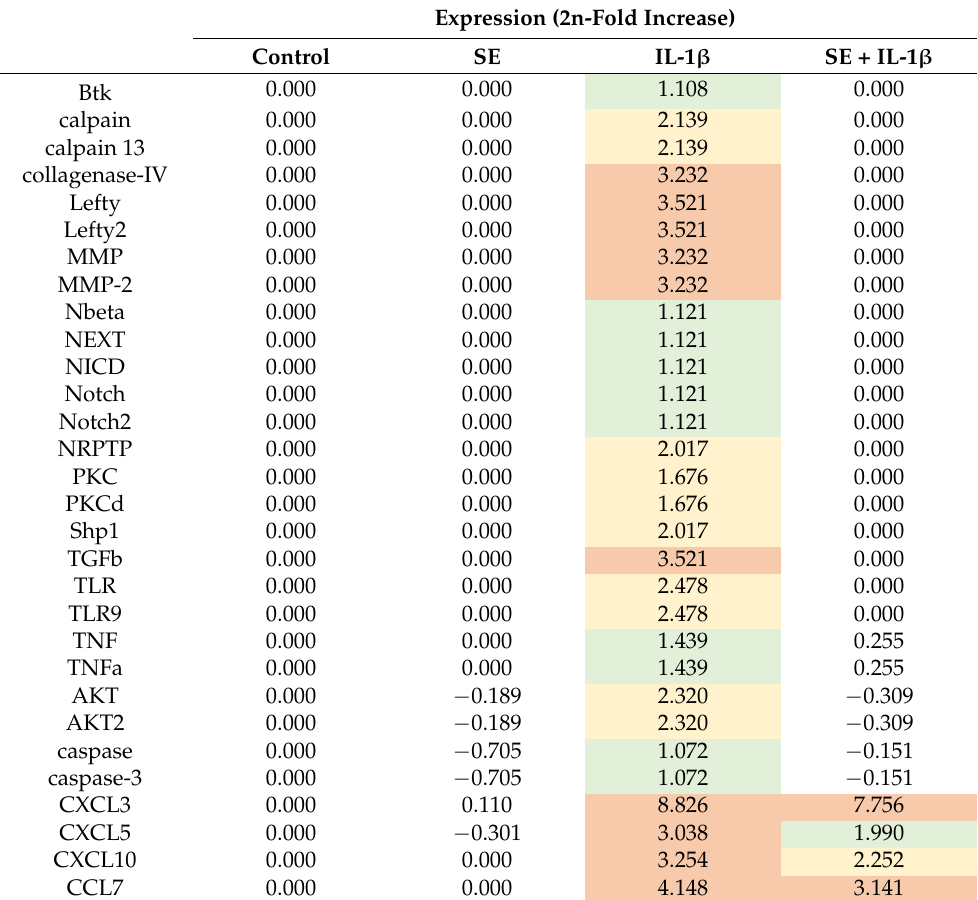
Table 2. Metabolites downregulated by IL-1 β and reversed by